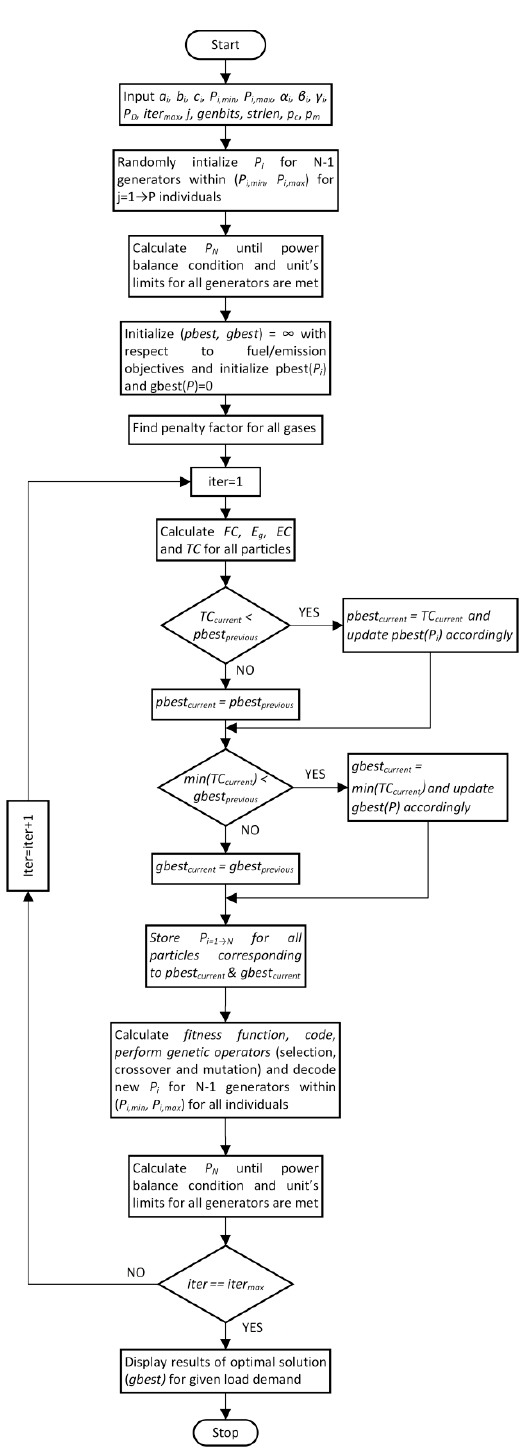
Figure 3. Implementation of CEED using genetic algorithm (GA) algorithm.